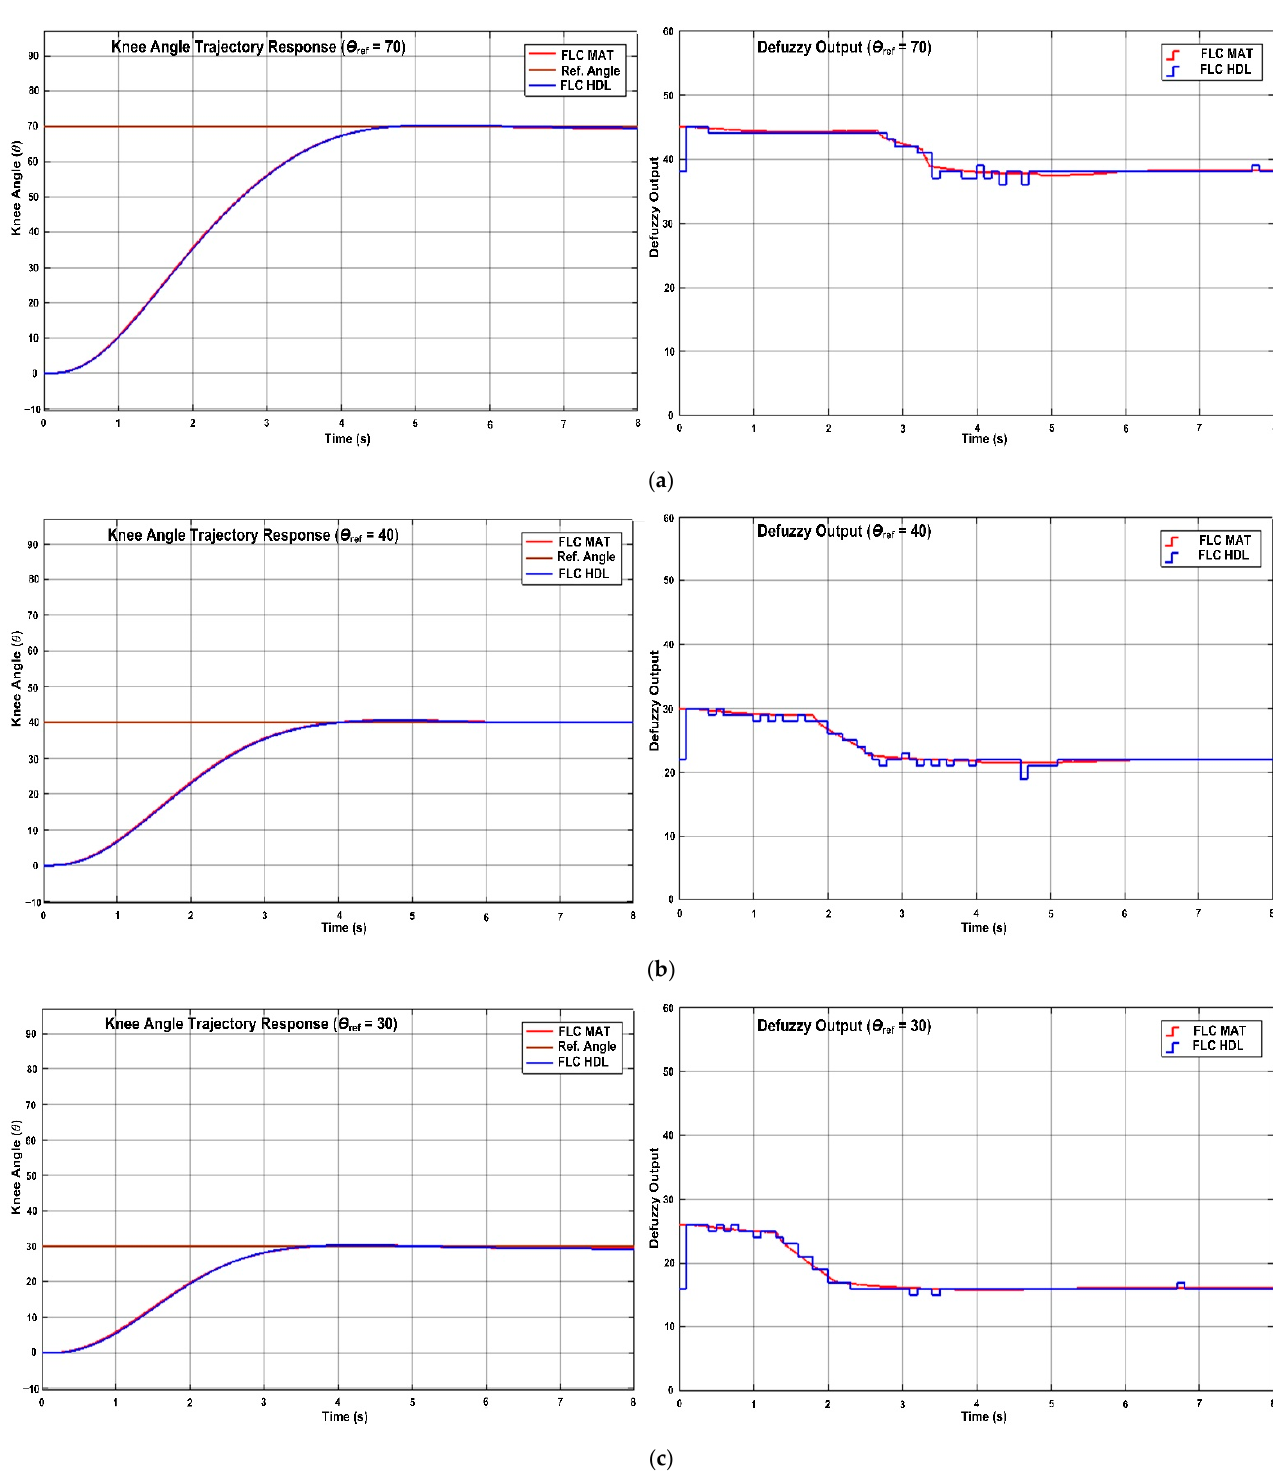
Figure 18. HDL co-simulation of knee angle trajectory and defuzzy output responses for three reference angles ( θ ref ): ( a ) Knee angle trajectory for θ ref = 70 ◦ ; ( b ) Knee angle trajectory for θ ref = 40 ◦ ; ( c ) Knee angle trajectory for θ ref = 30 ◦ . Simulation response using MATLAB (FLC MAT), simulation response using HDL (FLC HDL) and reference angle (Ref.